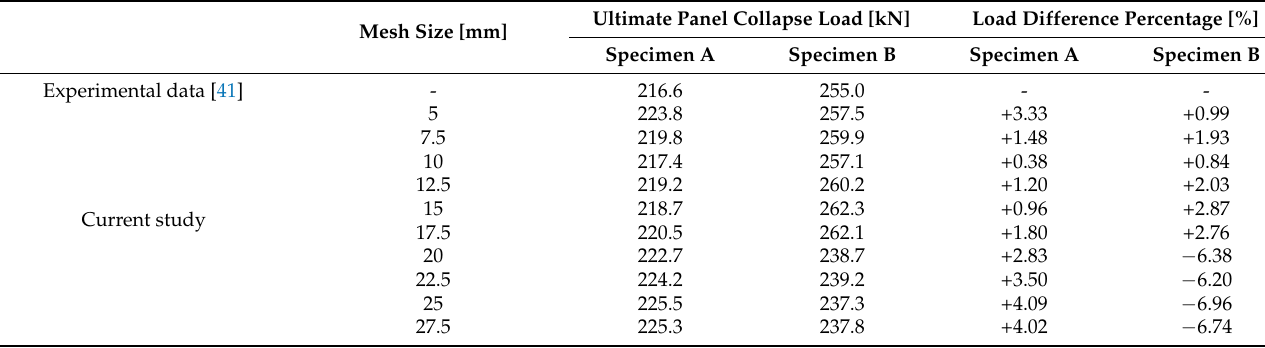
Table 5. Ultimate panel collapse loads and load difference percentage.